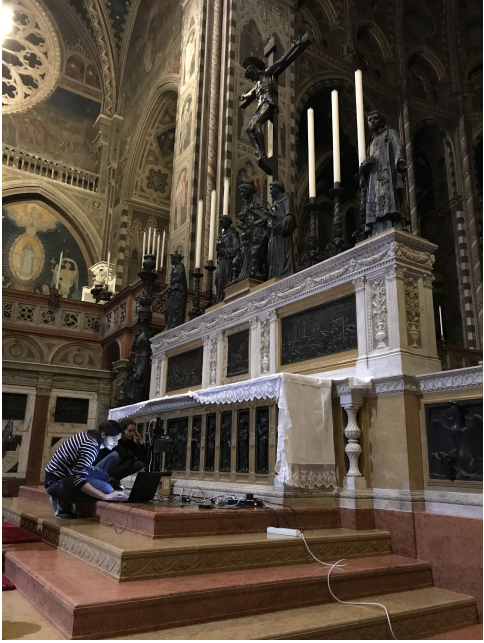
Figure 9. Measurements performed in situ at the Donatello’s High Altar in the “Basilica del Santo” in